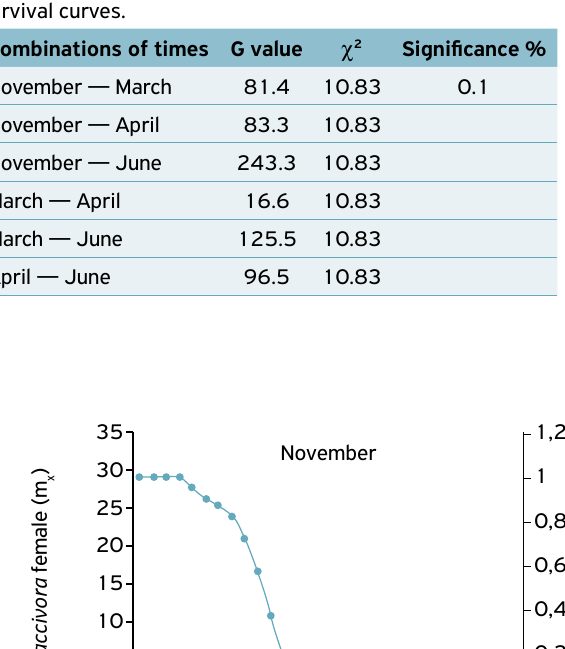
Figure 2. Mean number of nymphs produced/female (m Teresina, Piauí,